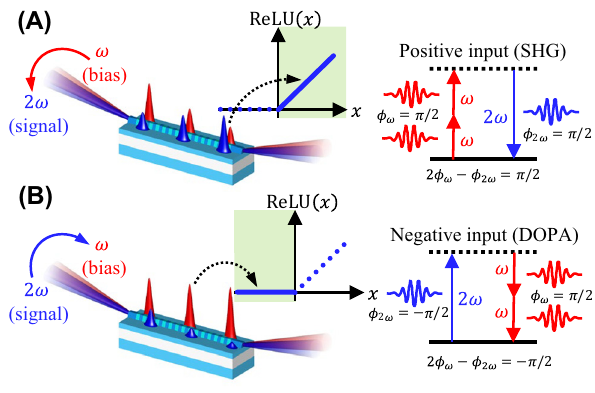
Figure 1: Operating principle of the all-optical ReLU function using a nonlinear photonic waveguide. = + 𝜋 ∕ 2, the phase (A) For positive inputs with phase of 𝜙 2 𝜔 = 𝜋 ∕ 2, relationship between the signal and bias is 2 𝜙 𝜔 − 𝜙 2 𝜔 which causes SHG that depletes 𝜔 and amplifies 2 𝜔 . (B) For = − 𝜋 ∕ 2, the phase relationship negative inputs, 𝜙 2 𝜔 = 3 𝜋 ∕ 2 → − 𝜋 ∕ 2 causes DOPA that amplifies 𝜔 and 2 𝜙 𝜔 − 𝜙 2 𝜔 depletes 2 𝜔